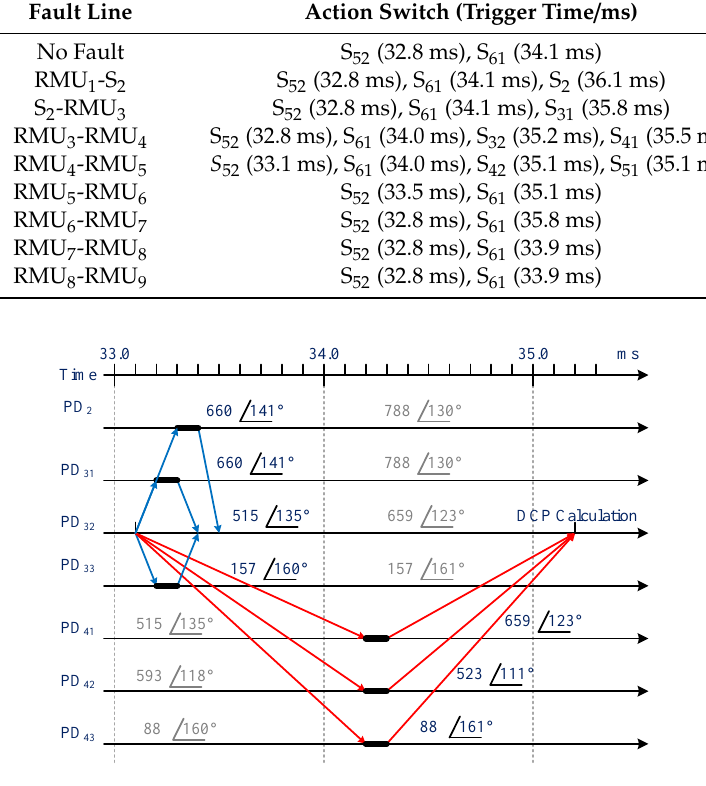
Figure 10. Communication sequence of PD 32 .